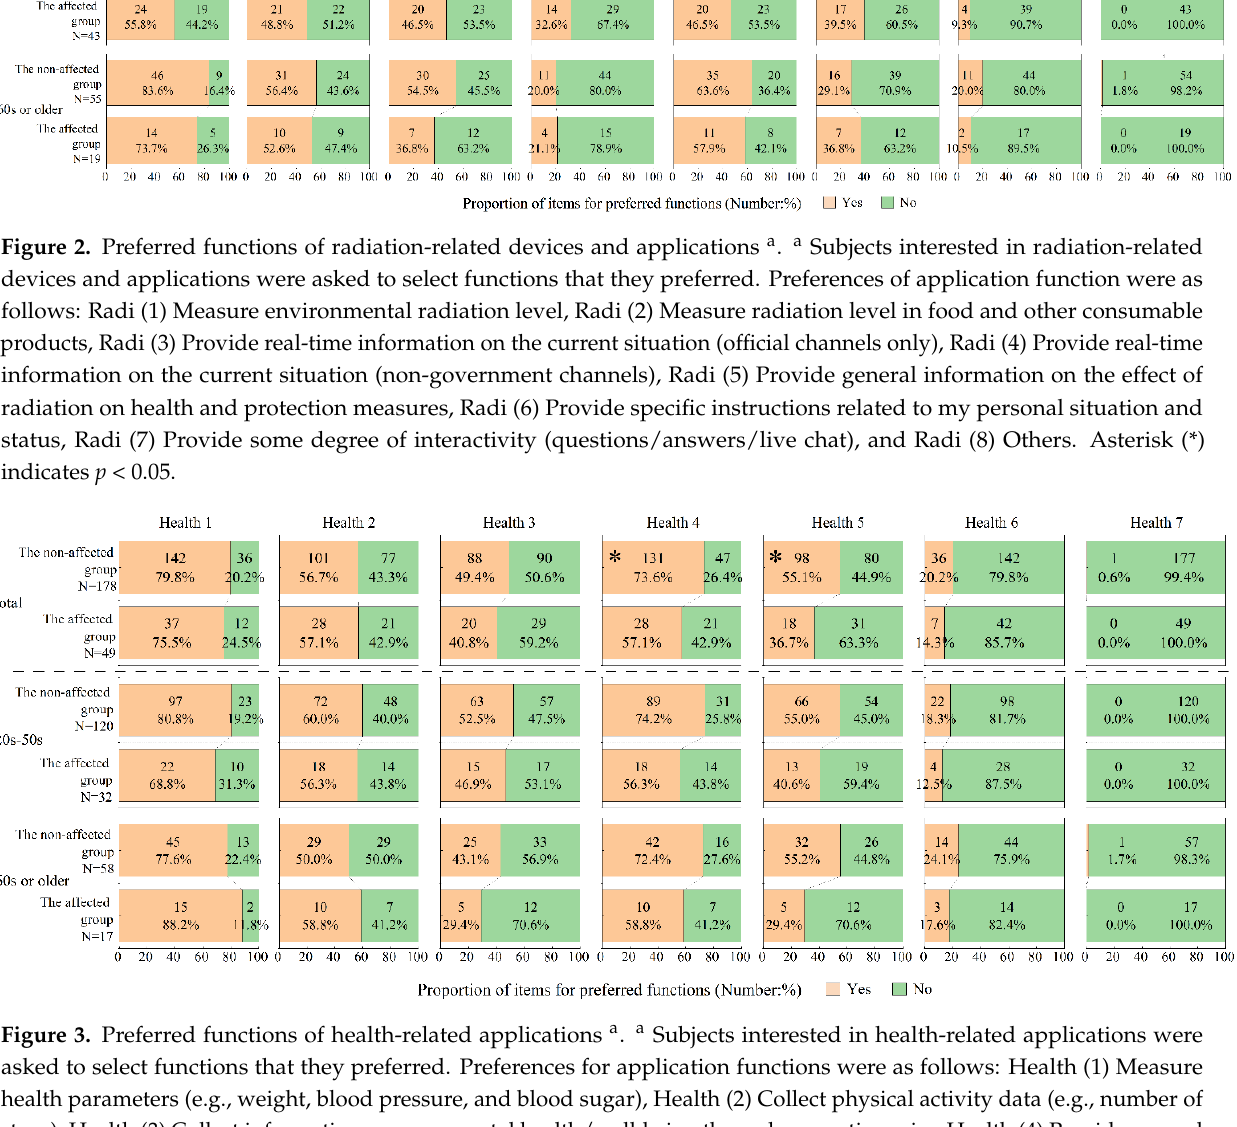
Table 5. Factors associated with attitude in the functioning of radiation- and the health-related ap- plications using logistic regression analysis. a . aOR b